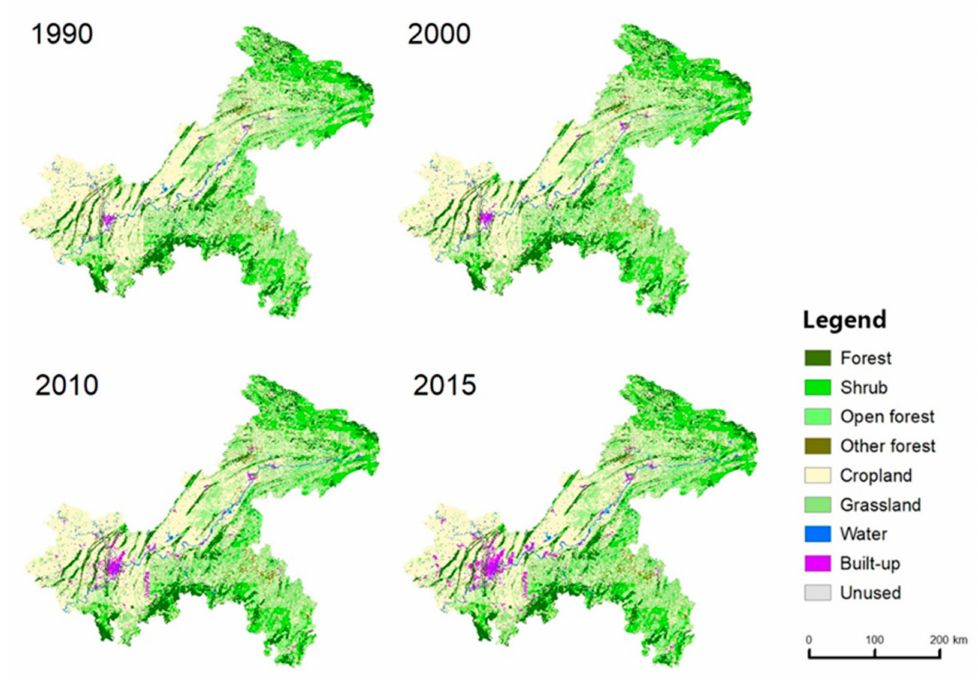
Figure 2. Land use and forest land maps in Chongqing (1990, 2000, 2010, 2015); Source: edited by